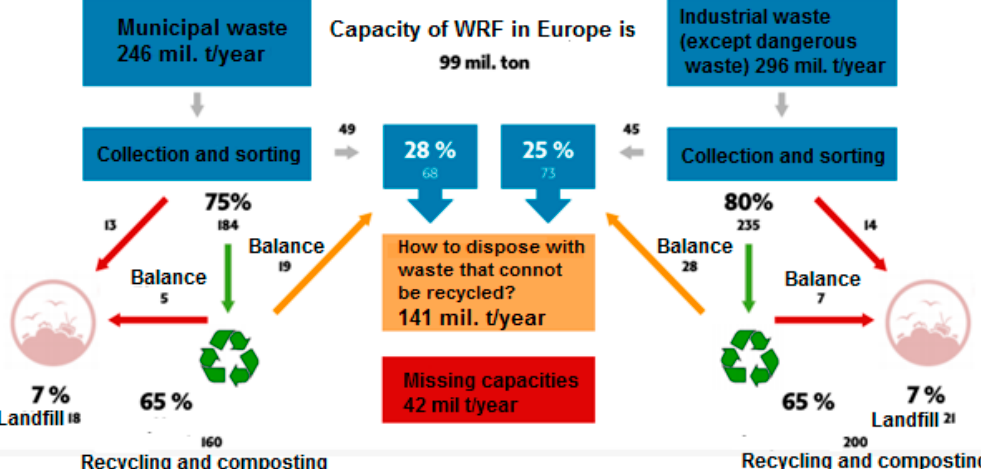
Figure 1. The usability of Waste Recovery Facility (WRF) capacities in the EU as well as missing capacities. Source: Based on EWIA (name of the company) model [26].